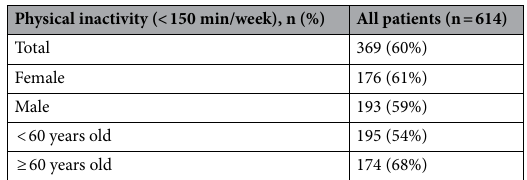
Table 2. Prevalence of physical inactivity according to sex and age.